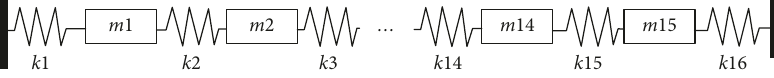
Figure 2: 15-DOF spring-mass system.